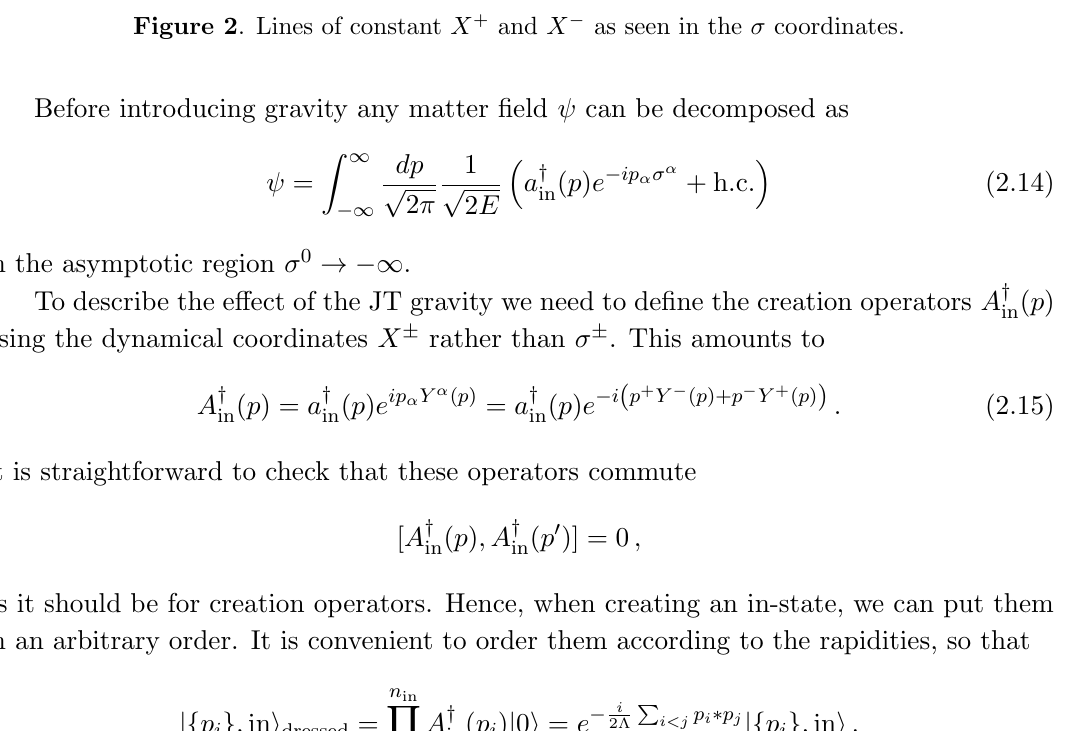
Figure 2 . Lines of constant X + and X (cid:0) as seen in the (cid:27)